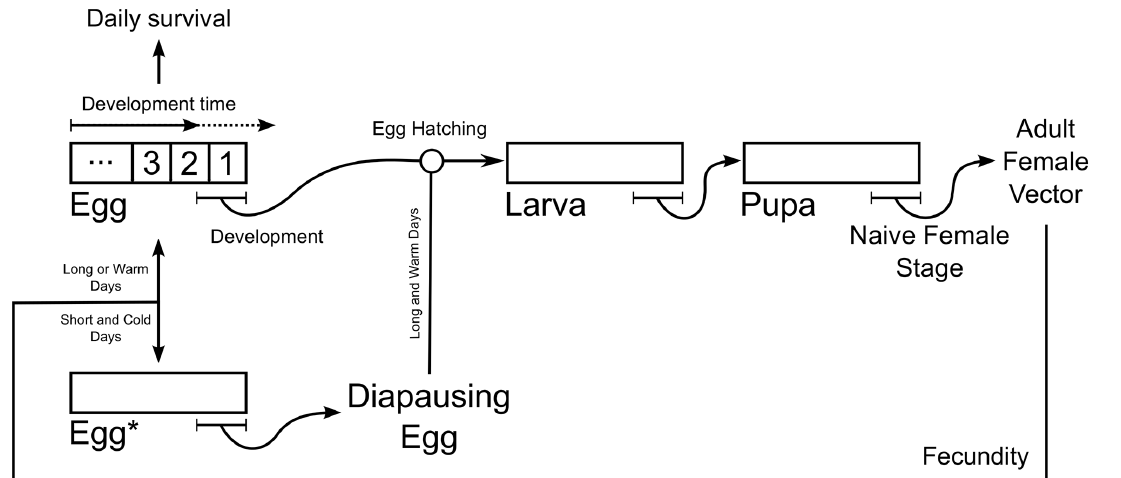
Fig 1. The stage- and age-structured time-difference equations model of Ae. albopictus .